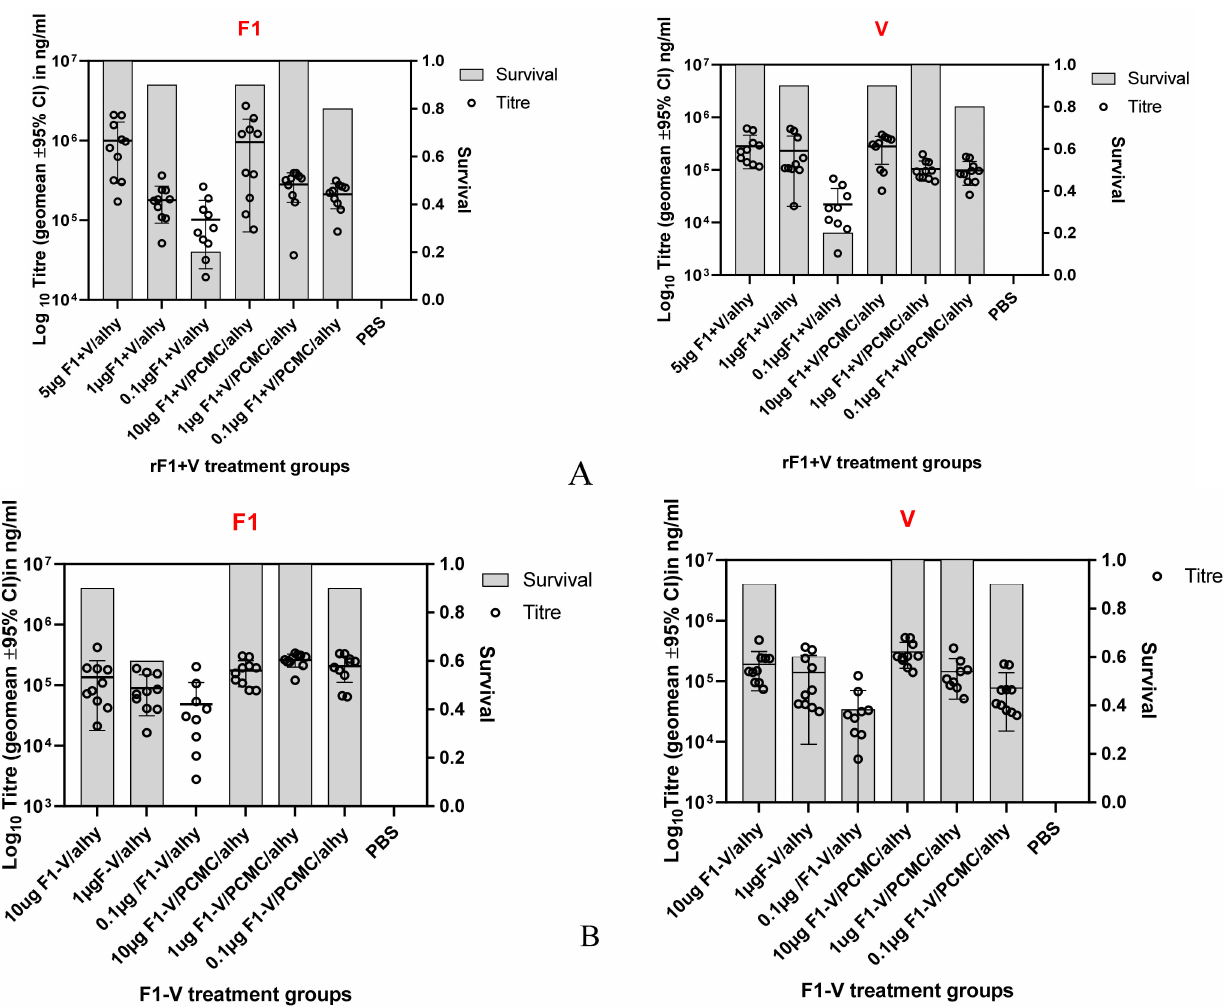
Figure 1. Heterogeneity of survival and antibody titres in immunised mice challenged with Y. pestis . The experiment consisted of 135 different immunisation conditions ( x -axis), and survival after challenge with Y. pestis (bars, as a proportion, n = 10) was recorded. In addition, the antibody titres prior to challenge were determined (data points) in ng/mL for F1 antigen (left) and in ng/mL for V antigen (right). Panel ( A ) shows the response of groups immunised with F1 and V, whilst panel ( B ) shows the response of groups immunised with F1-V. All titres are shown as the geometric means ±